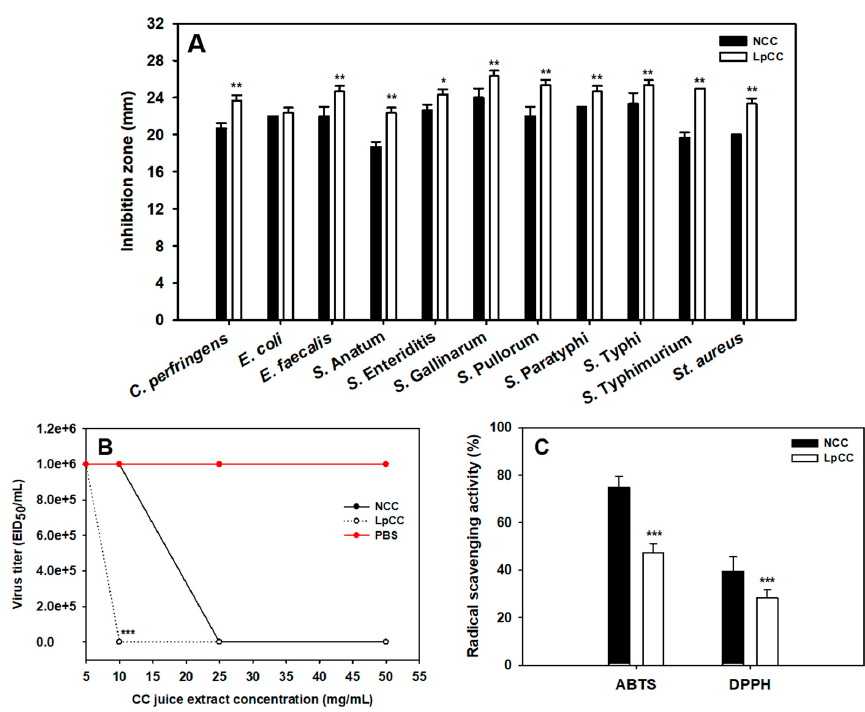
Figure 2. Changes in the bioactivities of CC juice following 24 h of L. plantarum fermentation. ( A ) Antibacterial activity of NCC and LpCC supernatants against poultry pathogens using agar well diffusion assay; ( B ) in ovo antiviral activity of NCC and LpCC extracts against low-pathogenic avian influenza virus, H1N1 using hemagglutination assay, EID 50 /ml: 50% egg infective dose per mL and ( C ) antioxidant activity of NCC and LpCC extracts using 2,2'-azino-bis(3-ethylbenzothiazoline-6-sulfonic acid (ABTS) and 2,2-diphenyl-1-picrylhydrazyl (DPPH) radical scavenging assays. (* p < 0.05, ** p < 0.01, *** p < 0.001), Statistically significant compared with NCC.